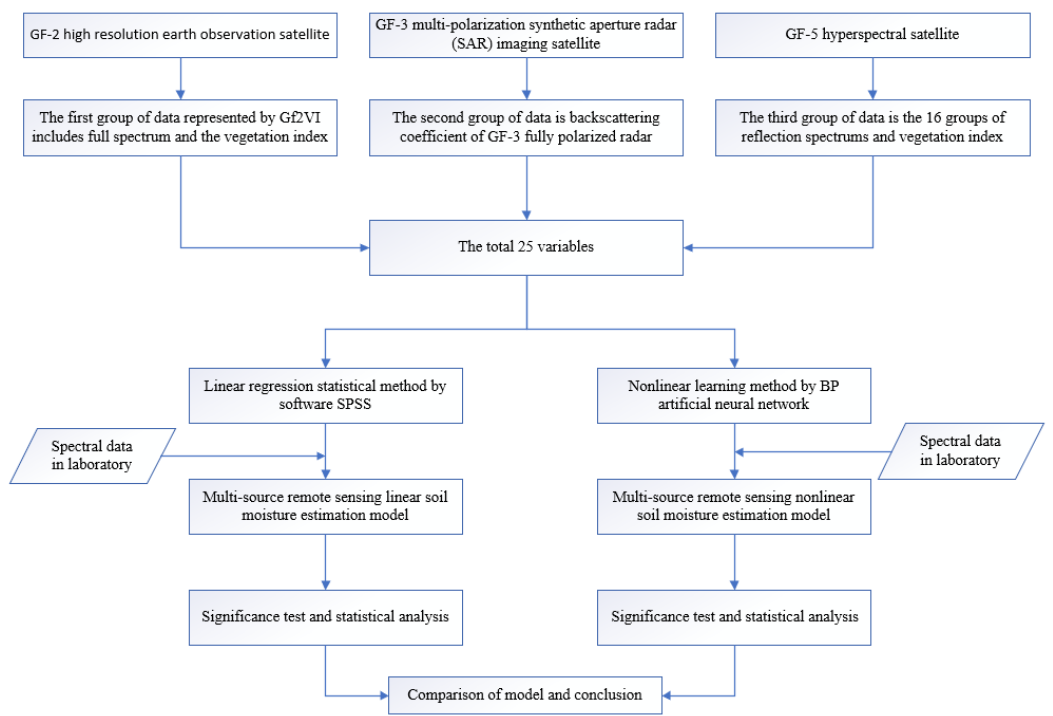
Figure 2. Flow chart of the soil-moisture estimation by using multi-source remote sensing.